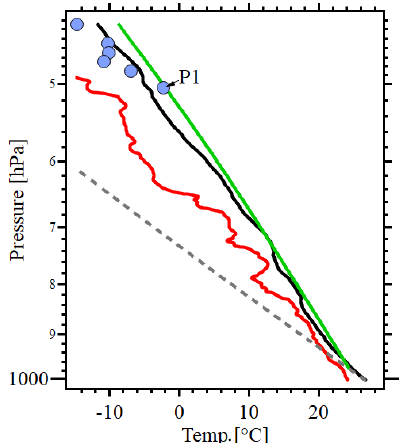
Figure 3. Pressure (hPa) vs. temperature ( ◦ C) during Case 1 ob- tained from dropsonde measurements of temperature (black trace); dew point (red solid line), derived temperatures during cloud pen- etrations (blue symbols), calculated dry adiabatic lapse rate (grey solid line) and saturated adiabatic lapse rate (green solid